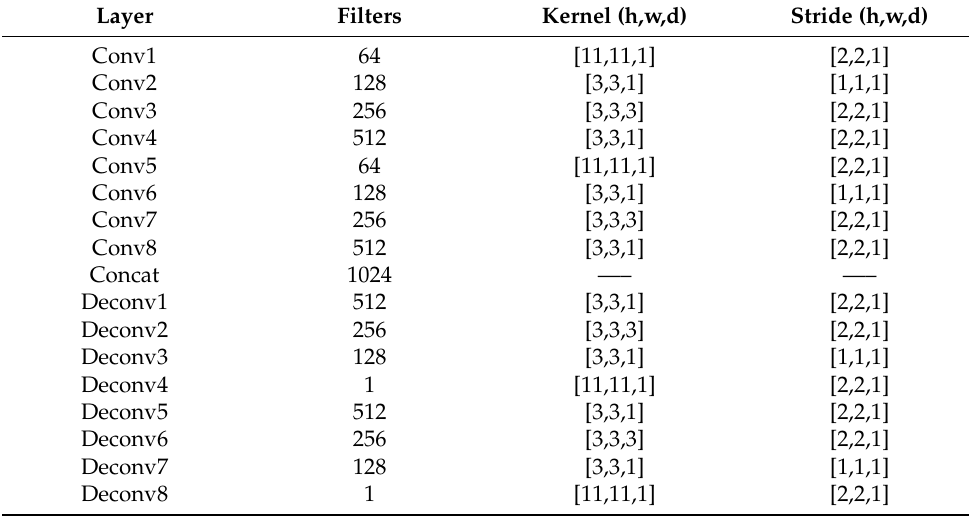
Table 1. Our architecture